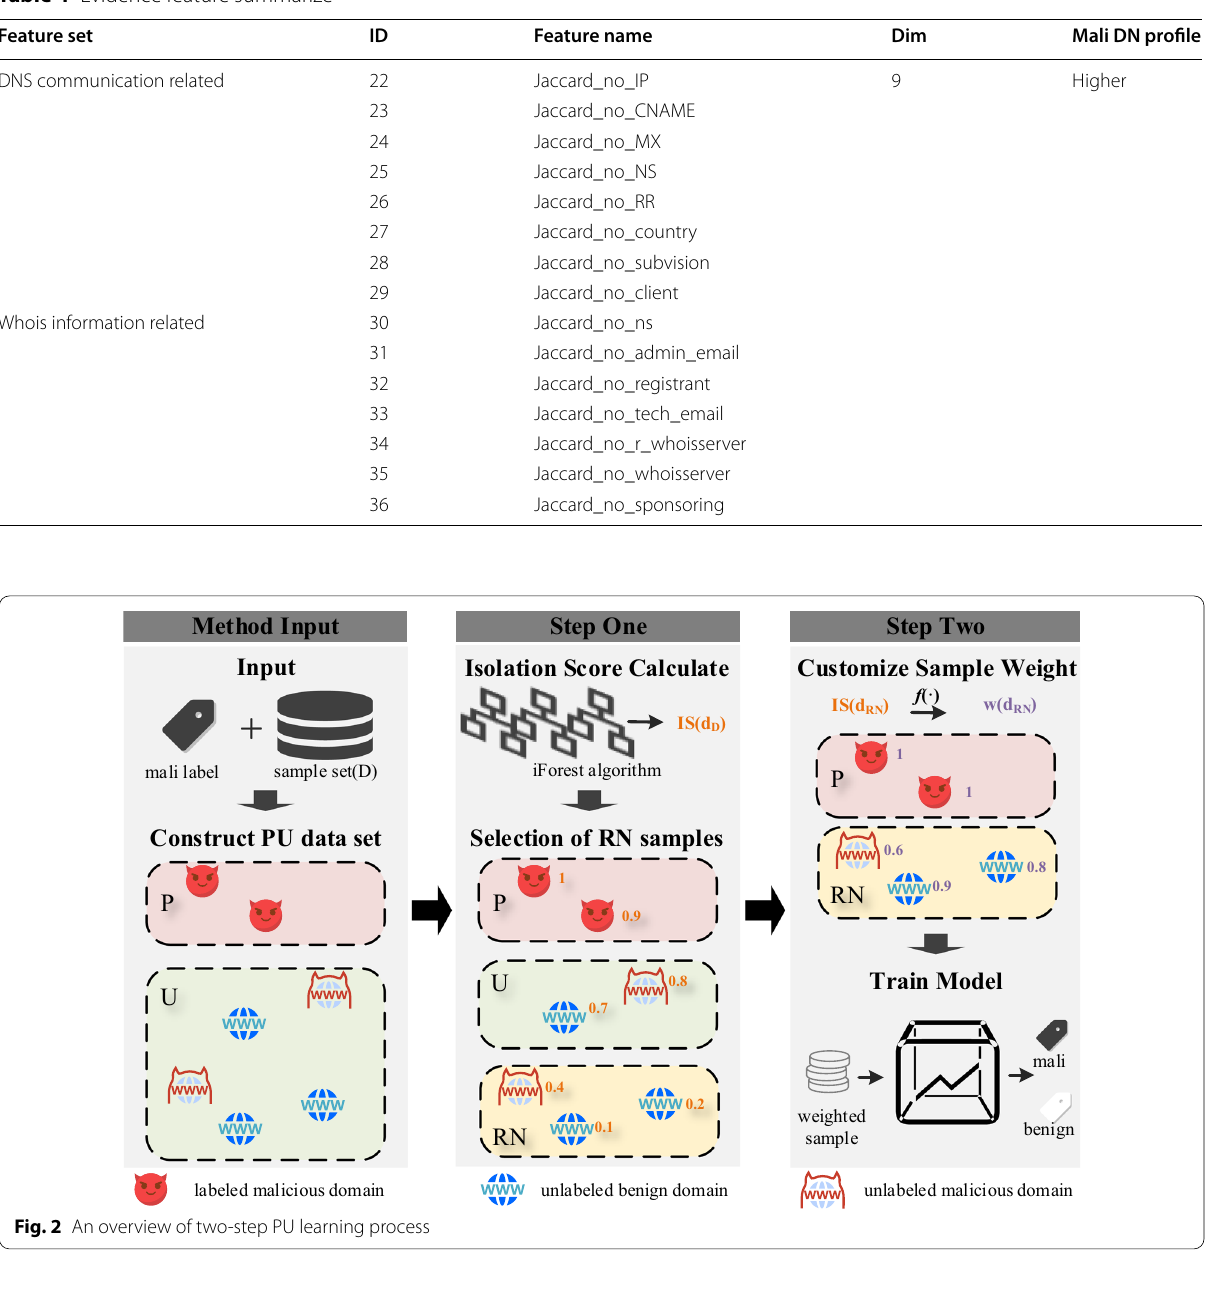
Table 4 Evidence feature summarize